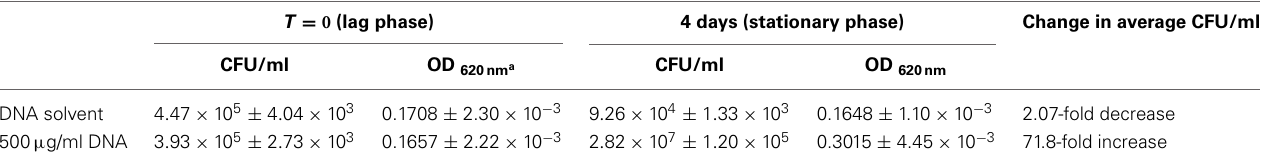
a Corresponding optical density at time of sampling. Error shown is SD of counts from triplicate